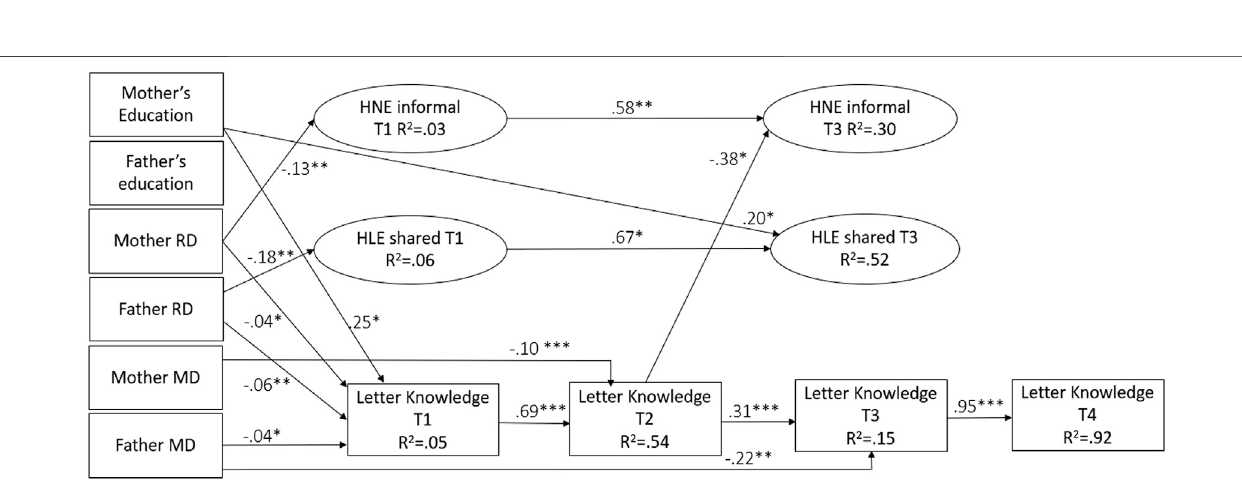
Frontiers in Education |